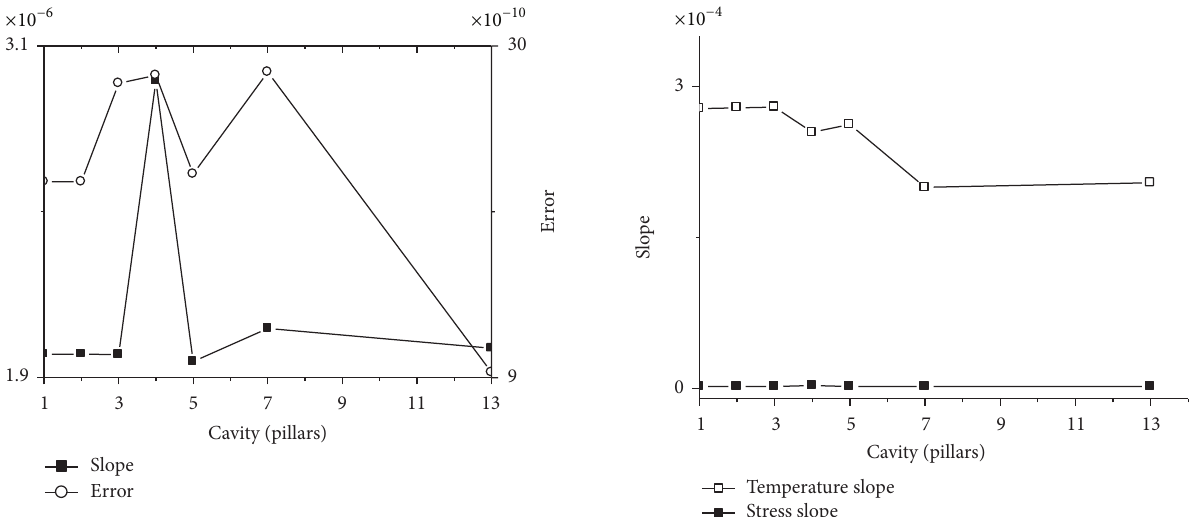
Figure 18: The slopes for the curves which are between resonant frequency and temperature and between resonant frequency and stress